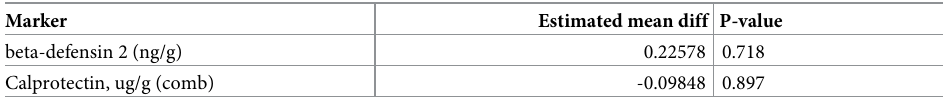
Table 5. Fecal biomarkers of